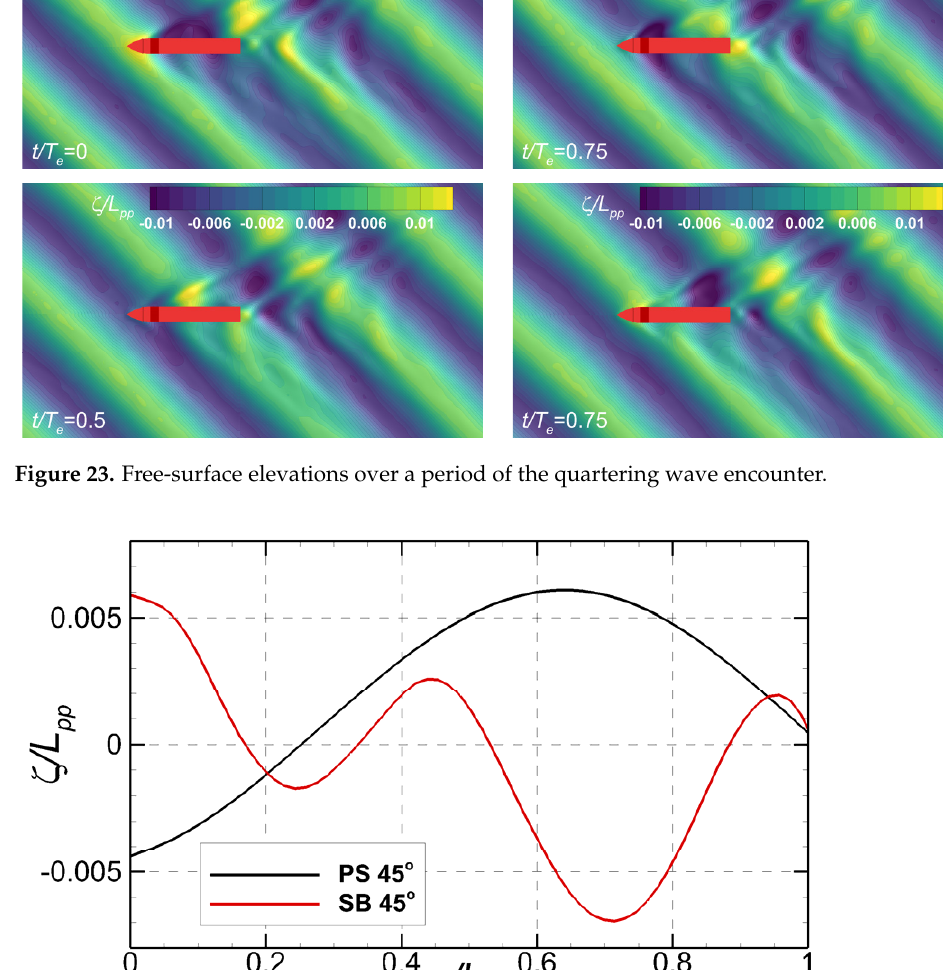
Figure 22. Comparisons between the time histories of the reconstructed resistance coefficient (𝐶 (cid:3021) ) , surge (𝑥) , heave (𝑧) , roll (𝜑) , and pitch (𝜃) measured (EFD) [33], and computed (CFD) over a pe- riod of the encounter in the 𝐹𝑅𝑥𝑧𝜑𝜃 beam waves scenario.